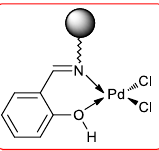
Figure 7. Pd-Sc@ASMNPs catalyst for acyl Sonogashira reactions developed by Sharma and coll. Pd-Sc@ASMNPs was used in the synthesis of ynones via acyl Sonogashira reactions performed